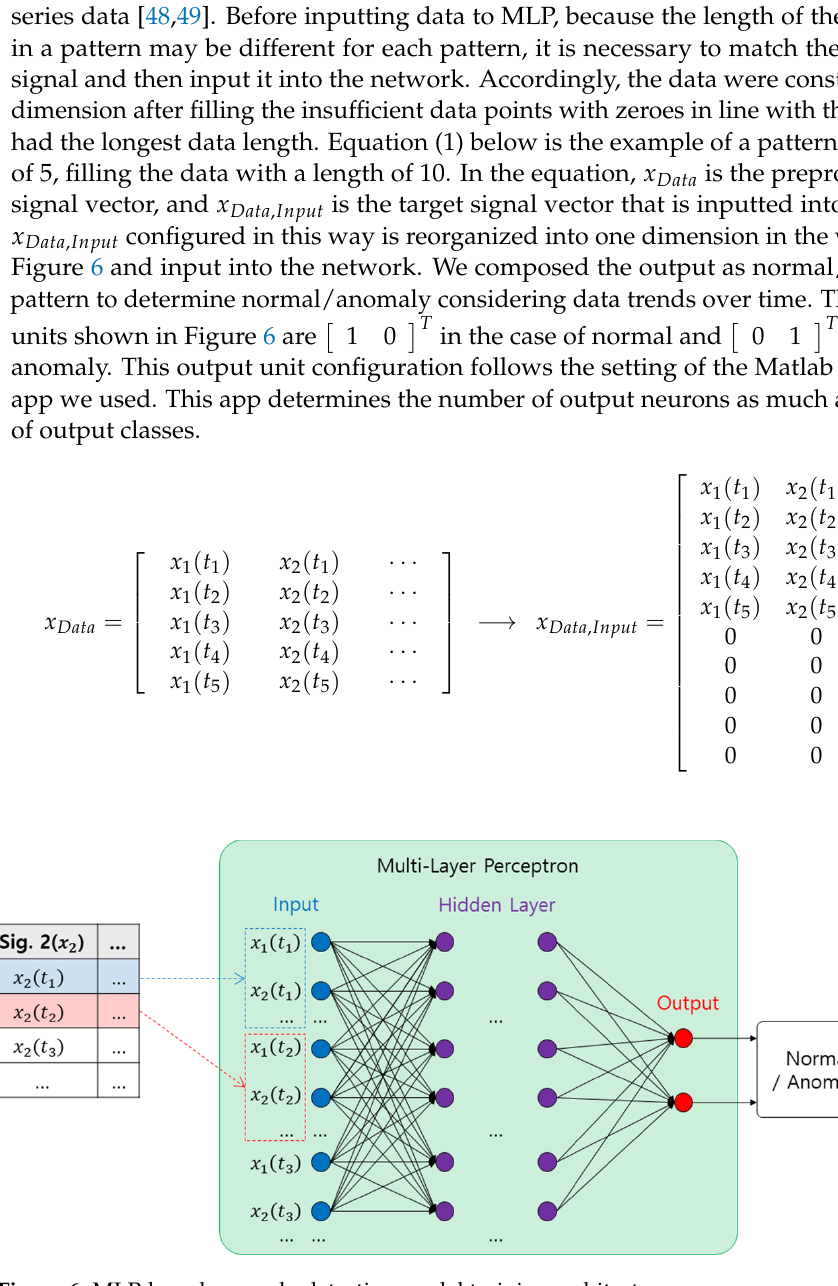
Figure 5. Activation functions for MLP: ( a ) hyperbolic tangent function; ( b ) sigmoid Function; ( c ) ReLU function.